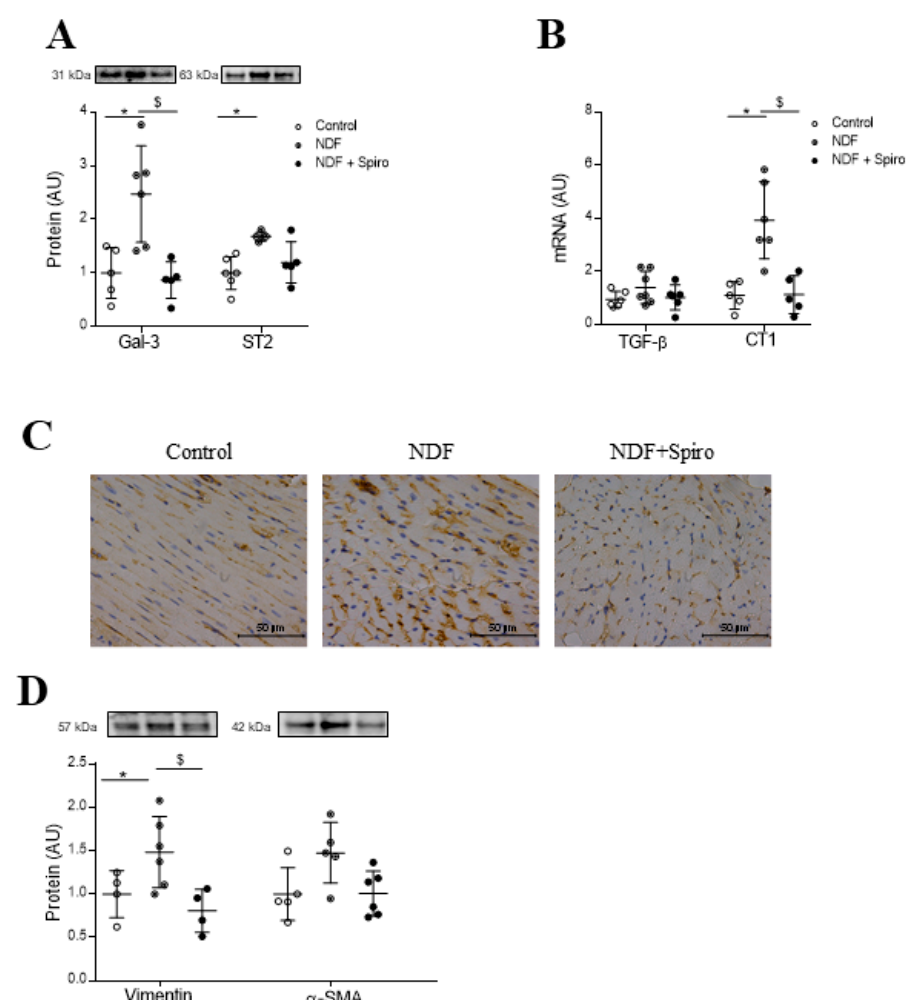
Figure 2. Effect of Spironolactone on profibrotic molecules and myofibroblast activation markers in a mouse model of myxomatous mitral valve disease. Quantification of Gal-3 (* p = 0.0338; $ p = 0.0217) and ST2 (* p = 0.0289) ( A ) protein levels in myocardium from controls, NDF-treated mice and NDF + Spiro-treated mice. Quantification of TGF- β (Transforming growth factor beta) and CT-1 (Cardiotrophin-1) (* p = 0.0014; $ p = 0.0016) ( B ) mRNA levels from controls, NDF-treated mice and NDF + Spiro-treated mice. Representative microphotographs of α -smooth muscle actin ( α -SMA) immunostaining in myocardium from controls, NDF-treated mice and NDF + Spiro-treated mice ( C ). Quantification of vimentin (* p = 0.0033; $ p = 0.0051) and α -SMA protein levels in myocardium from controls, NDF-treated mice and NDF + Spiro-treated mice ( D ). The box plots show the individual datapoints and the horizontal bars indicate the mean and SEM in arbitrary units versus the control group. Magnifications 40 × (Scale bar 50 µ m). The results were analyzed using one-way ANOVA, followed by Tukey’s multiple comparisons tests. * vs. control, $ vs. NDF.